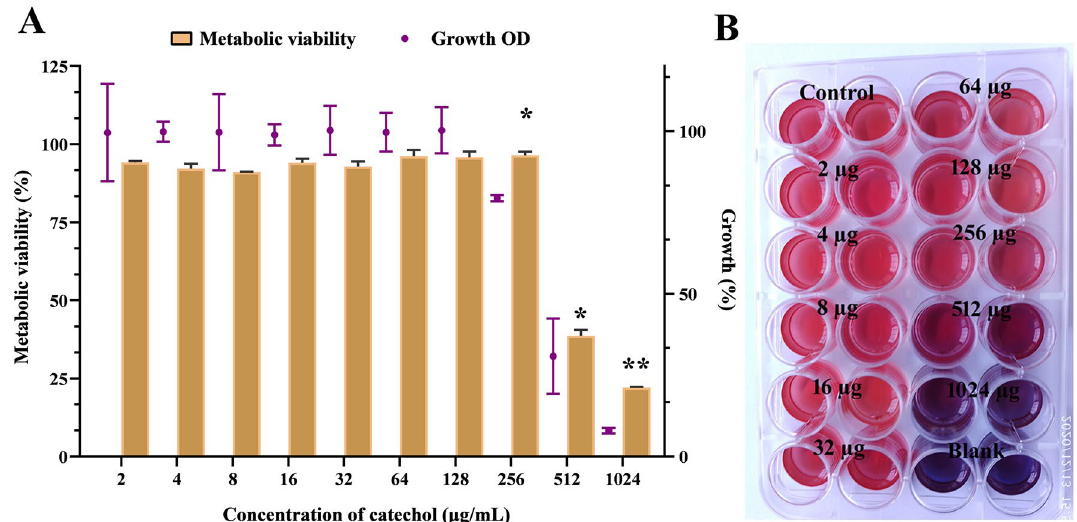
Figure 1. The influence of catechol (0–1024 μg/mL) on C. albicans planktonic growth. ( A ) Measurement of C. albicans cell density and metabolic viability after grown for 24 h in the presence and absence of catechol using broth micro dilution and alamar blue assay, respectively. Error bars indicates the mean values of three experimental triplicates. The “* “and “**” symbols represents the statistical significance of p < 0.05 and p < 0.01, respectively. ( B ) Representative MTP stained with alamar blue show the true metabolic state of catechol treated C. albicans